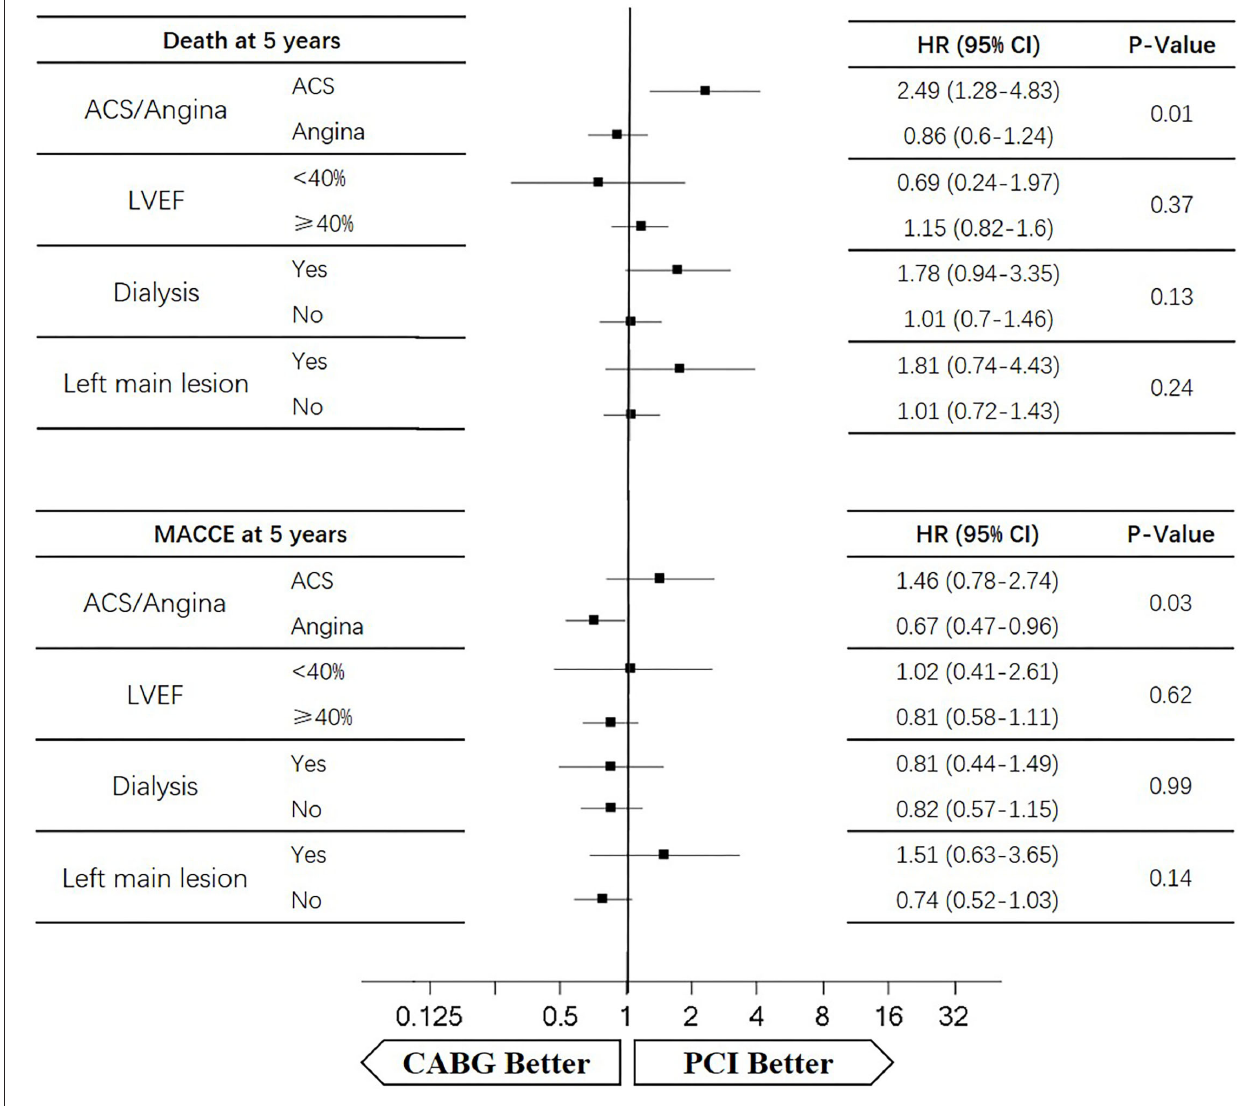
FIGURE 6 | The 1-year death and MACCEs for patients according to